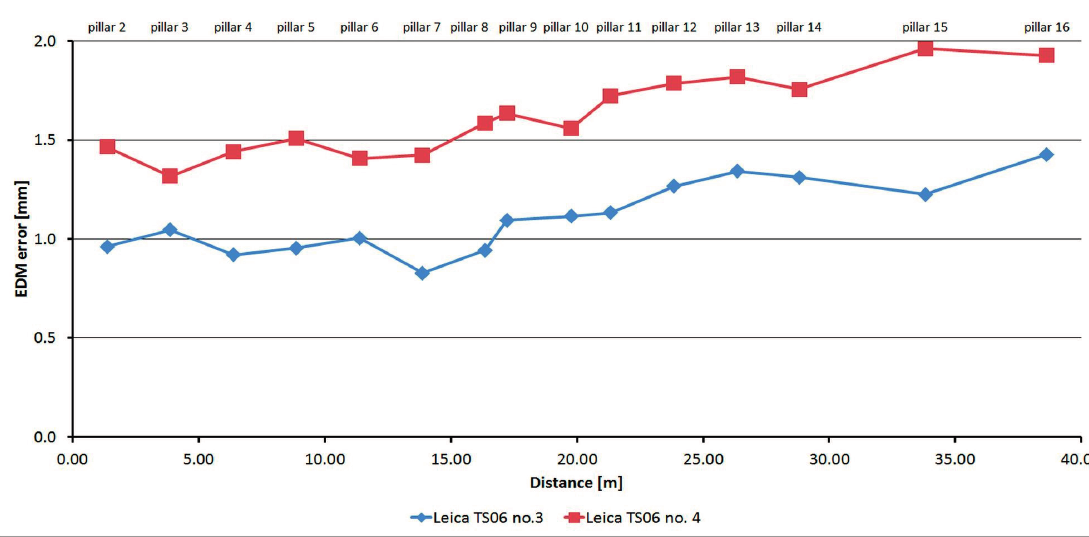
Figure 26. Comparison of absolute errors of two Leica TC1202 instruments.